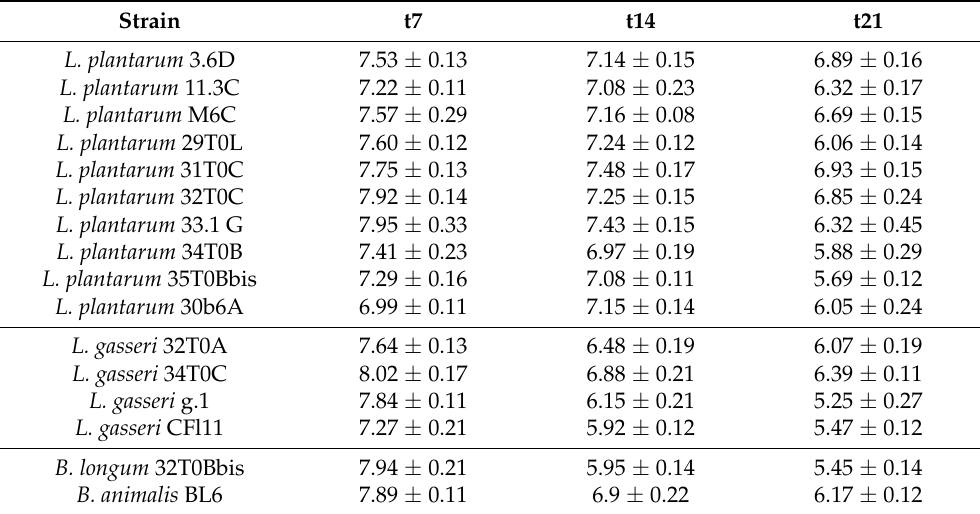
Table 8. Microbial viability of the lactobacilli and bifidobacteria under study inoculated in pasteurized whole milk (log CFU/mL) after 14 (t14), 21 (t21) days of refrigerated storage (4 ◦ C). The cell counts are expressed as the average of three replicates; the values are reported ± standard deviations (SD).